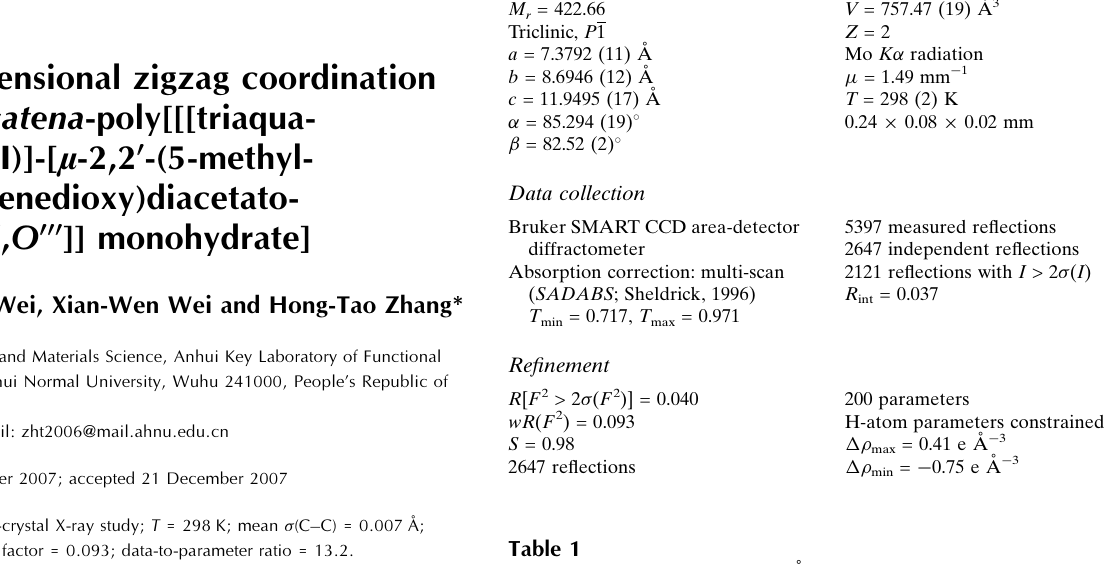
Selected geometric parameters (A˚ , (cid:2) ).